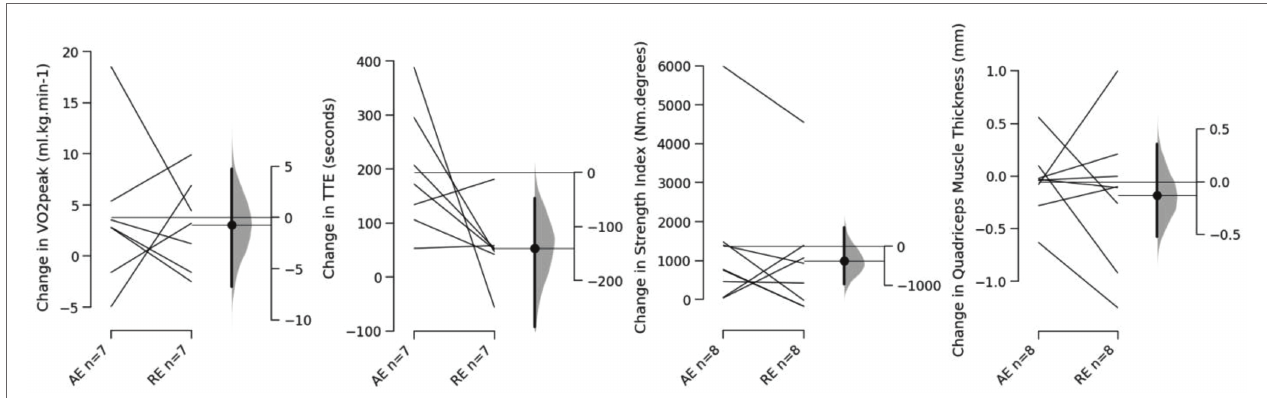
FIGURE 1 | From left to right, individual responses and paired comparisons (floating axis showing mean difference with 95% confidence intervals) for change in VO 2 peak, time to exhaustion during progressive ramp unilateral cycle test, isometric knee extension strength index (area under torque curve), and quadriceps muscle thickness; AE, Aerobic Exercise/“Cardio” Group; RE, Resistance Training